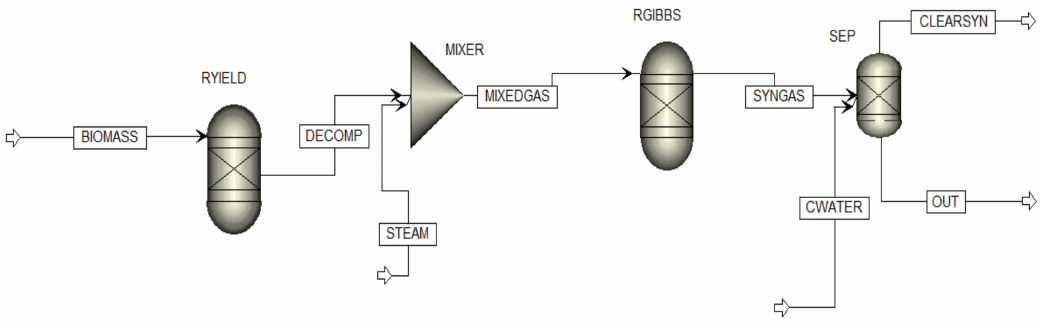
Figure 5. Aspen Plus flow sheet for steam FBG scenario.